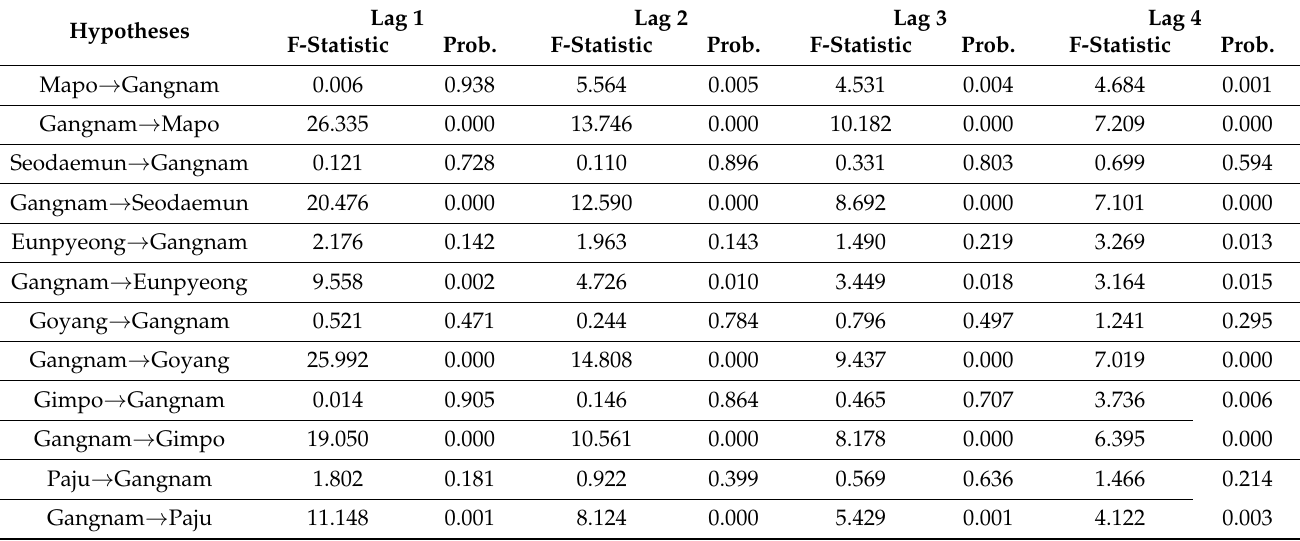
Table 5. Granger causality analysis of jeonse prices in Gangnam, Northwest region, and Gyeongeui region.